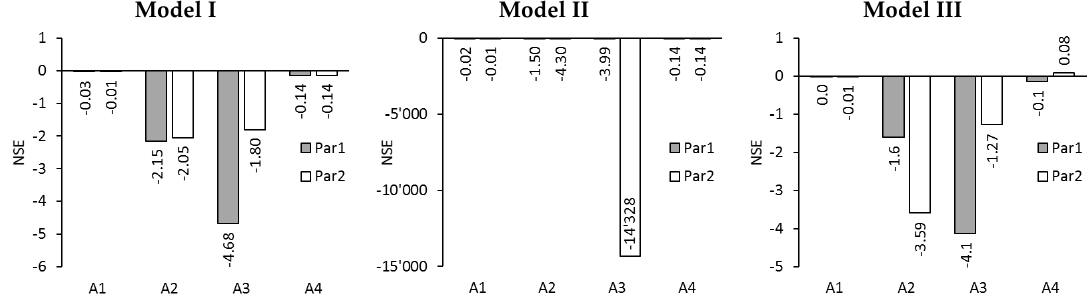
Figure 6. NSE for reverse solute fluxes of test series A1, A2, A3, and A4 simulated with Model I, Model II, and Model III using membrane parameter sets Par1 and Par2.